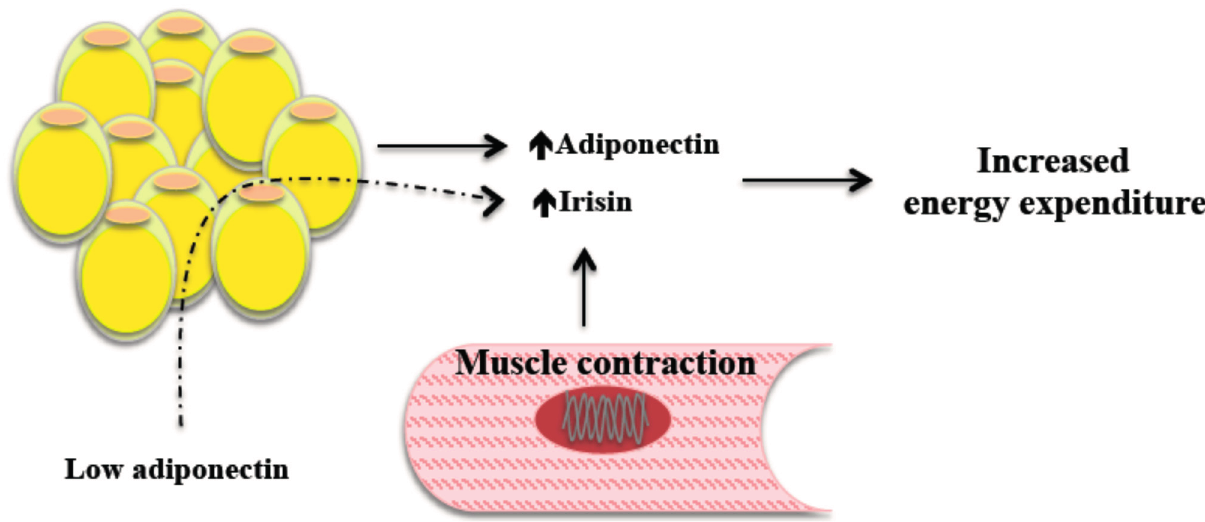
Figure 2. The elevation of irisin in response to low adiponectin can create a biofeedback loop to increase energy